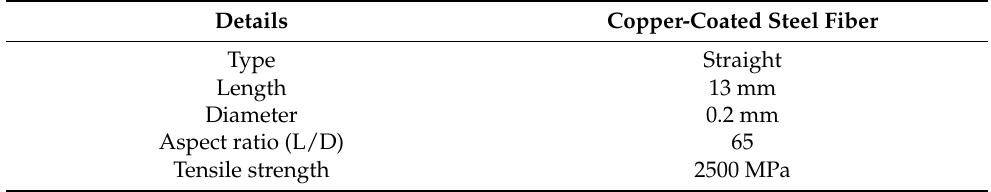
Table 2. Steel fiber details.